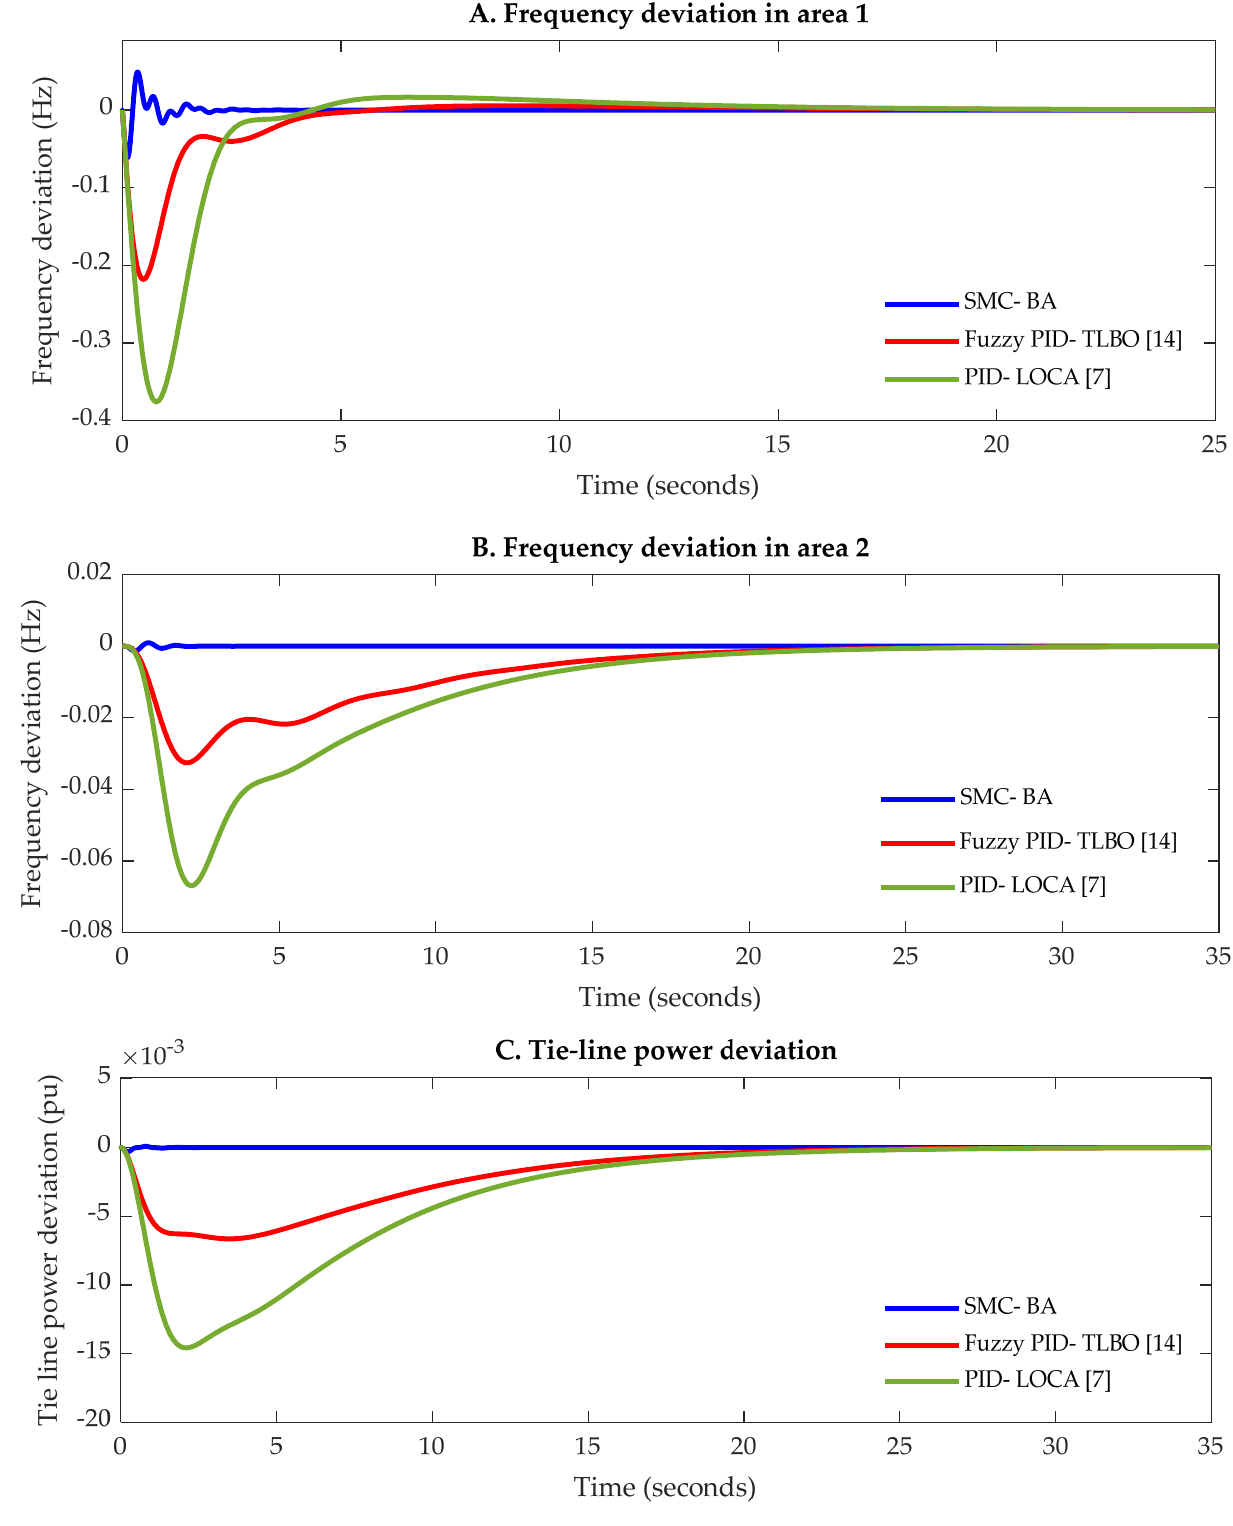
Figure 7. Dynamic response of the system with different controllers under parametric uncertainties, case 1. ( A ) Frequency deviation in area 1; ( B ) Frequency deviation in area 2; ( C ) Tie line power deviation.